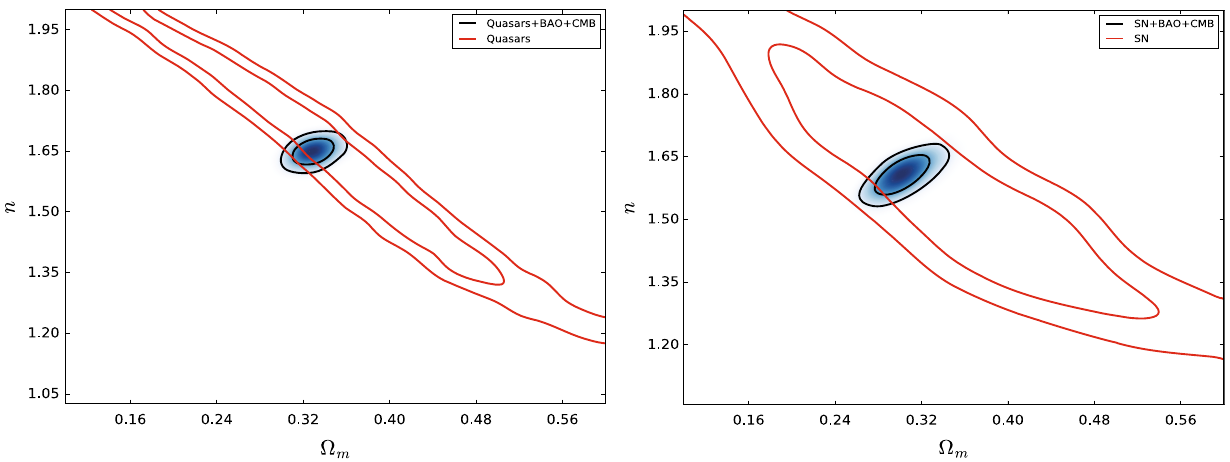
Fig. 7 1 σ and 2 σ confidence regions for the f 3 CDM model. The red lines represent contour plot given by quasars ( left panel ) and SN Ia ( right panel ). The black lines represent constrained result from the joint analysis quasars+BAO+CMB ( left panel ) and SN Ia+BAO+CMB ( right panel )